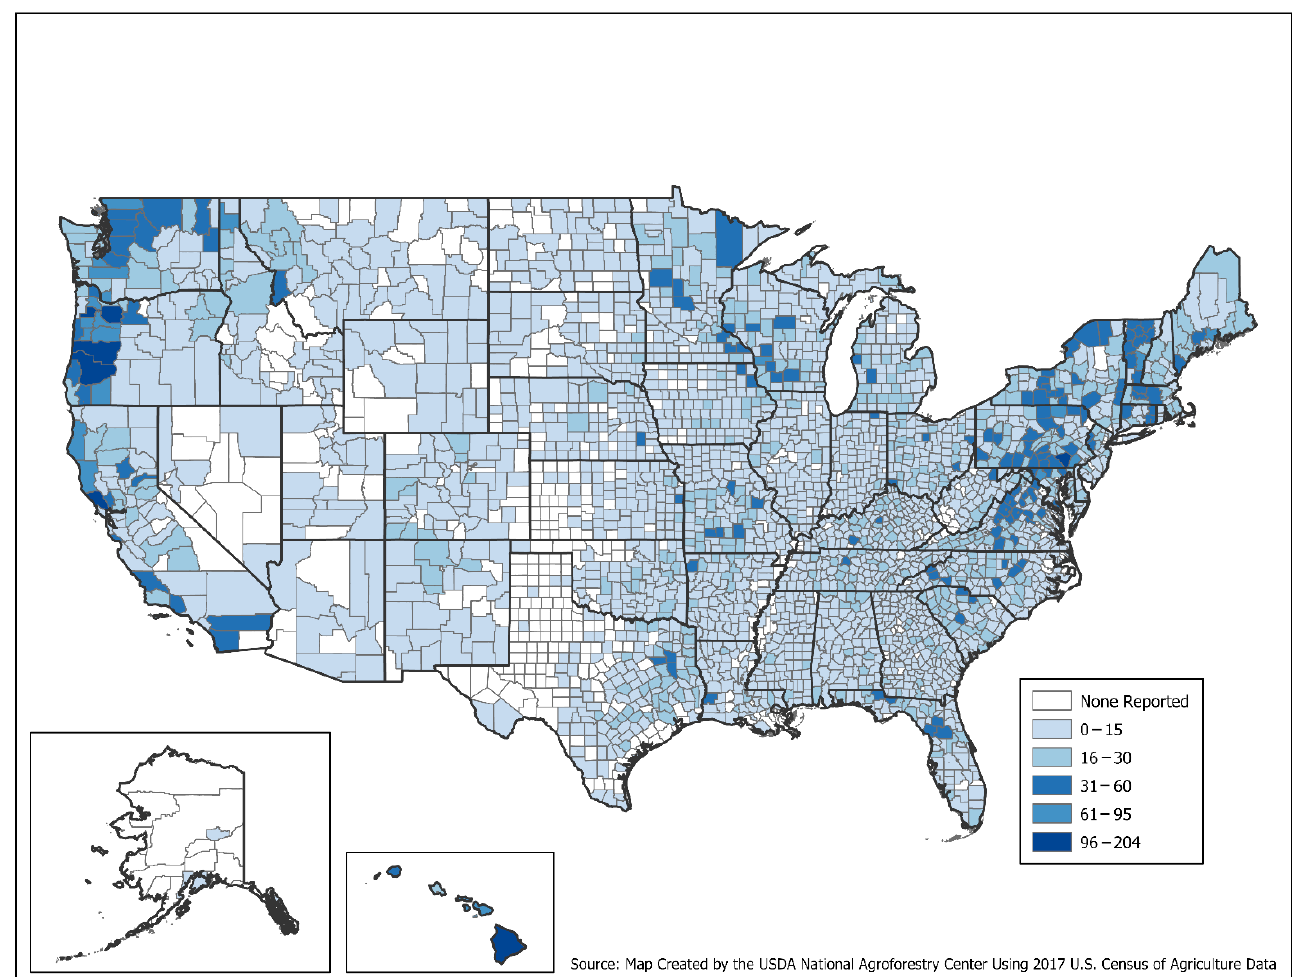
Figure 1. Number of U.S. farms by county reporting using at least one of the five common agrofor- estry practices (windbreaks, riparian forest buffers, alley cropping, silvopasture and/or forest farm- ing) [17] .